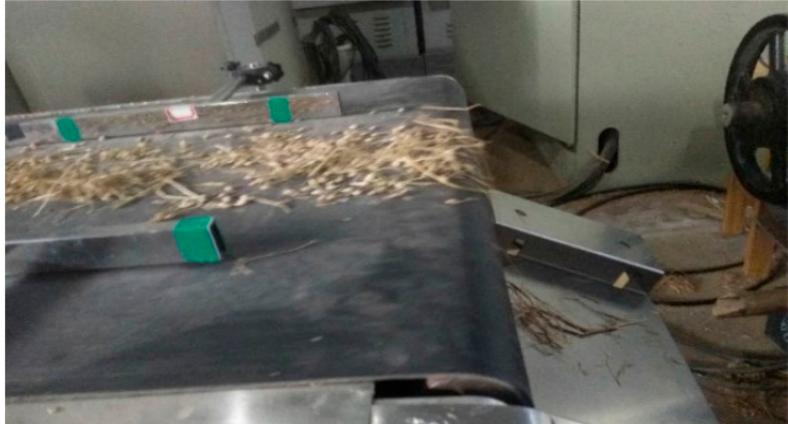
Figure 21. Experimental test bench of grain/MOG falling on the sensor plate [7]. Table 1. Review of the existing grain loss sensors and measurement